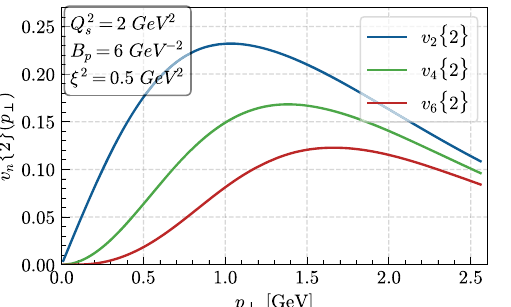
Fig. 5 Dependence of the differential 2-particle even azimuthal harmonics, v 2 n { 2 } , on transverse momentum p ⊥ . In this graph we have used B p = 6 GeV − 2 , ξ = Q s / 2, Q 2 s = 2 GeV 2 and N c =